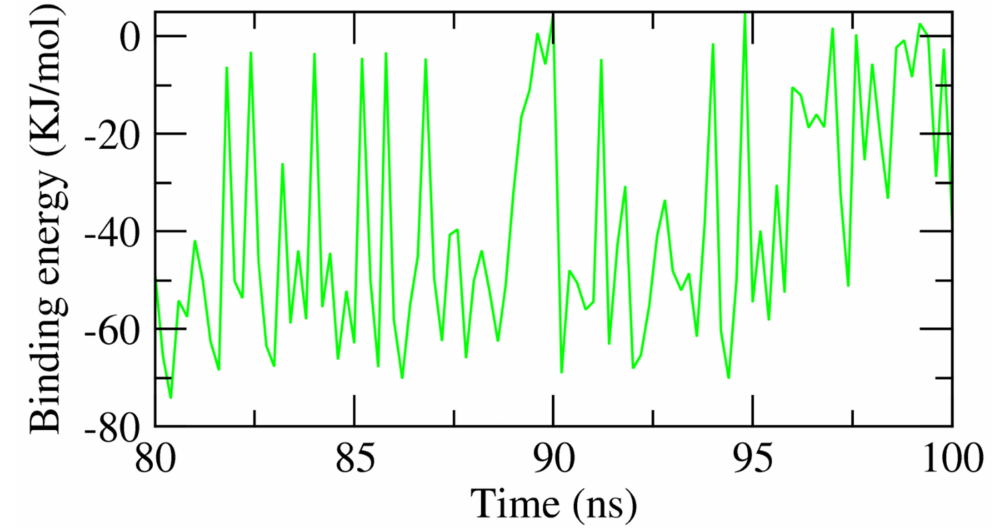
Figure 12. MM-PBSA findings of anabasine- β CD